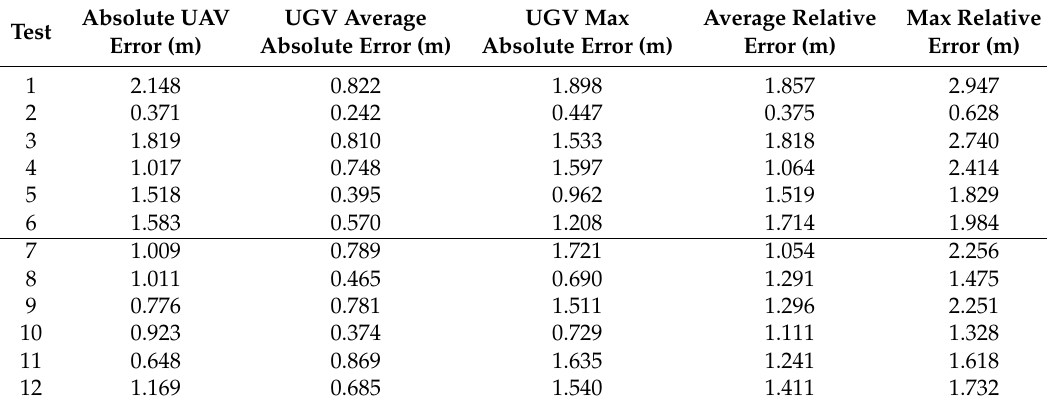
Table 2. Results from passes made by both vehicles at the obstacle. The absolute errors refer to the distance between each vehicles’ estimate of the position of the obstacle and the true real-time kinematic global positioning system position. The relative error is a comparison between the estimated positions from each vehicle.